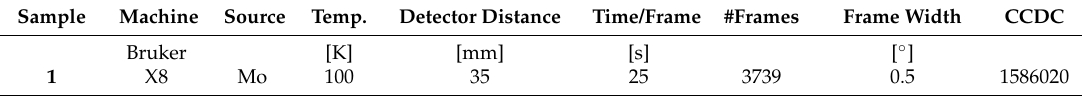
Table 1. Experimental parameter and